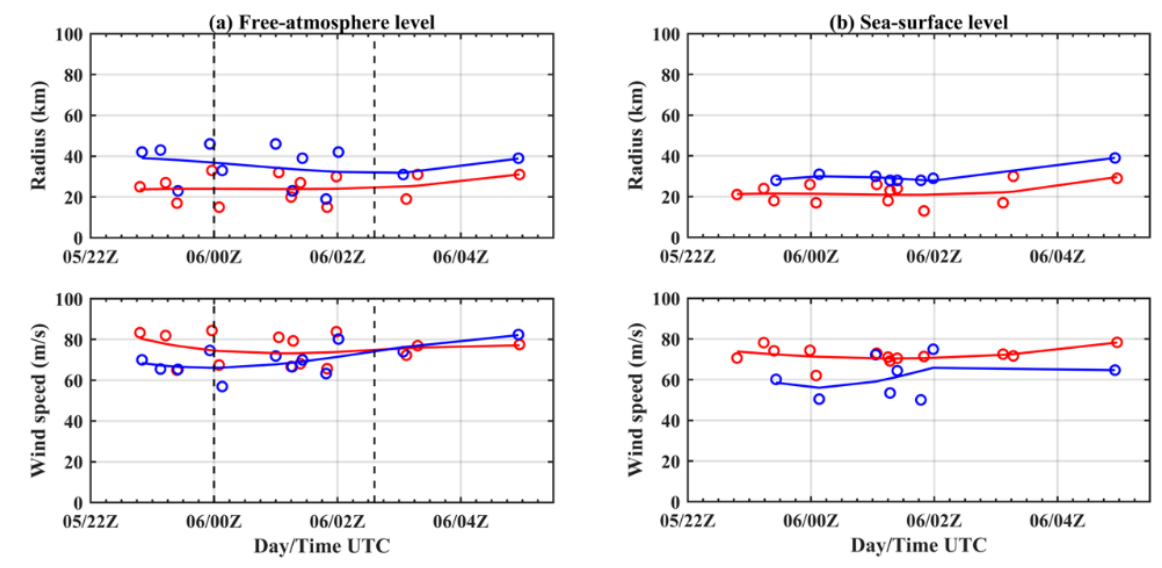
Figure 8. The same as Figure 6 but for the ERC03 event.